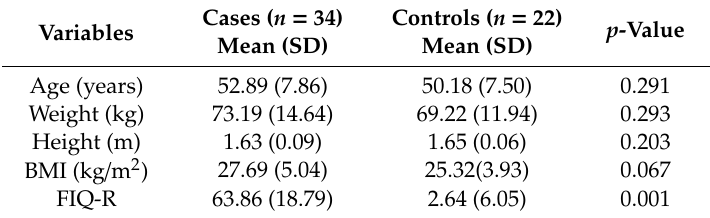
Table 1. Sociodemographic and clinical characteristics of the study